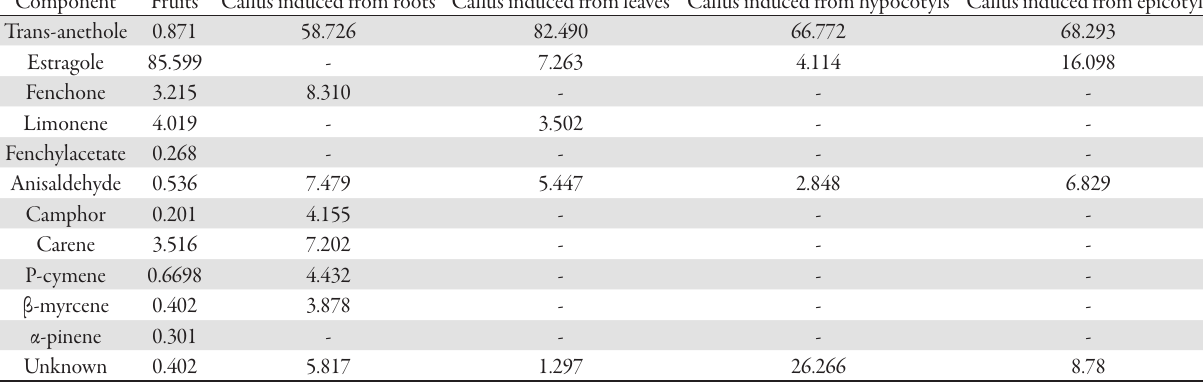
Tab. 4. Relative percentage composition of the volatile oils from callus induced from different seedling parts of fennel ( Foeniculum vulgare )